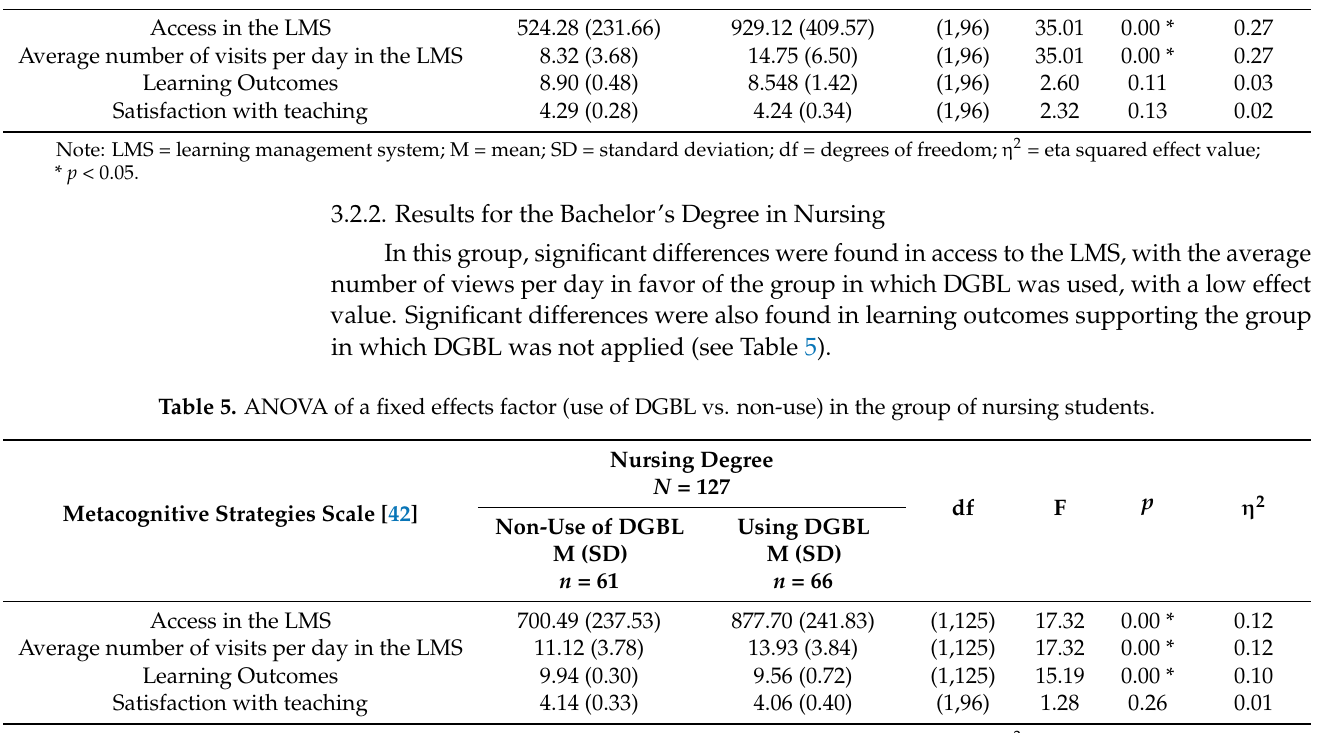
Metacognitive Strategies Scale [42]